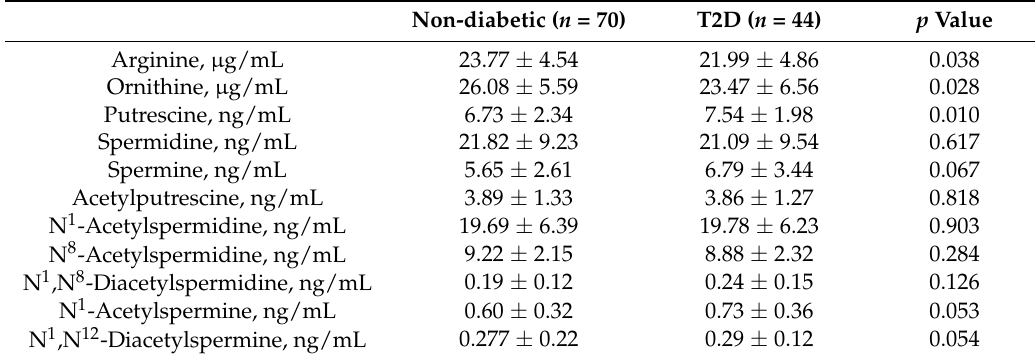
Table 2. Baseline serum polyamine levels of the study subjects, according to the presence or absence of T2D.